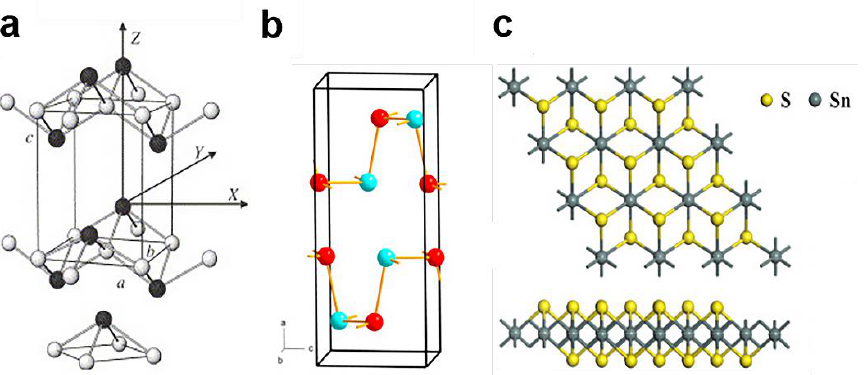
Figure 7. ( a ) Ball-and-stick model for litharge structure of SnO [64]. Copyright © 2021 Elsevier B.V. and Physica B: Condensed Matter. ( b ) The Pnma orthorhombic structure of GeSe [65]. Copyright © 2021 Elsevier B.V. and The Chinese Ceramic Society. ( c ) Top view and side view of SnS 2 [66]. Copyright © 2021 Elsevier B.V. and Materials Chemistry and Physics.